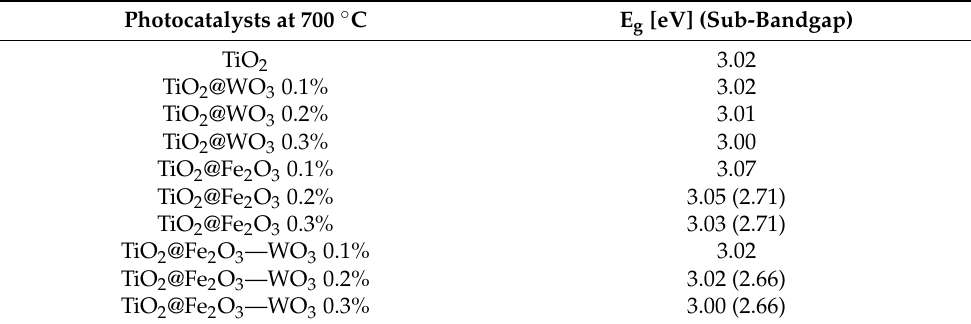
Table 2. Estimated energy band gap (E g ).